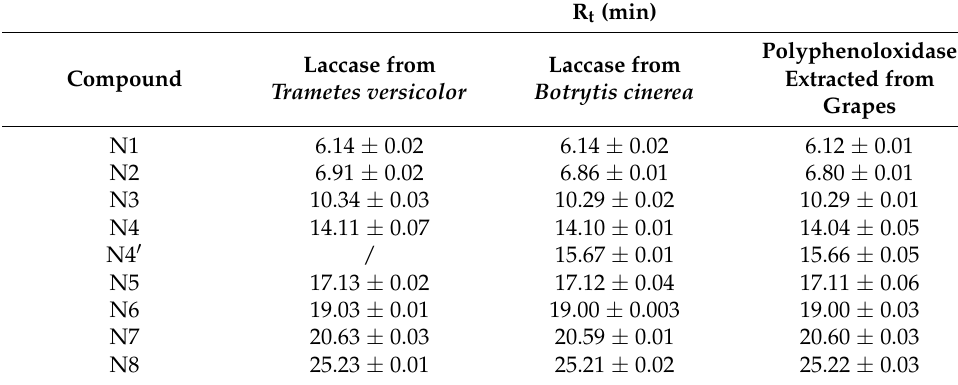
Table 2. Qualitative comparison of analytical reversed-phase UHPLC retention times for the eight major oxidation products with the three different oxidative enzymes: laccase from Trametes versicolor , laccase from Botrytis cinerea , and polyphenoloxidase extracted from grapes. The results are expressed as mean values ( n = 3) with standard deviation. R t (min) Polyphenoloxidase Laccase from Laccase from Compound Extracted from Trametes versicolor Botrytis cinerea